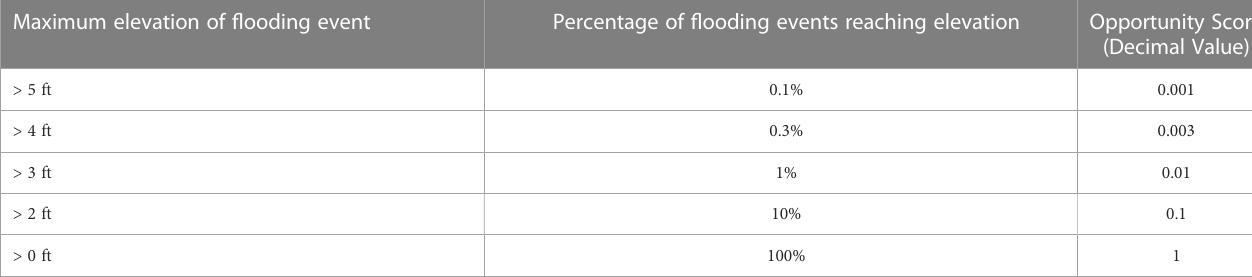
TABLE 3 Opportunity scores represent how often an NNBF encounters coastal fl ooding waters and has the opportunity to mitigate coastal fl ooding impacts and is based on the elevation of the NNBF. Maximum elevation of fl ooding